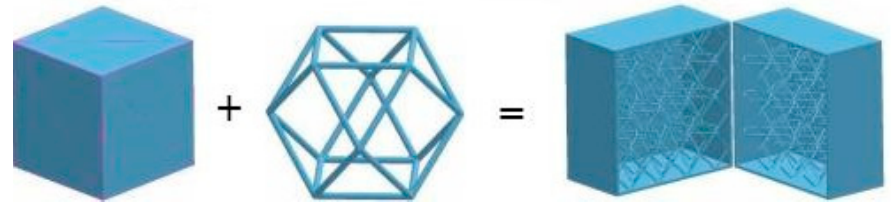
Figure 13. 3D texture mapping method [157].